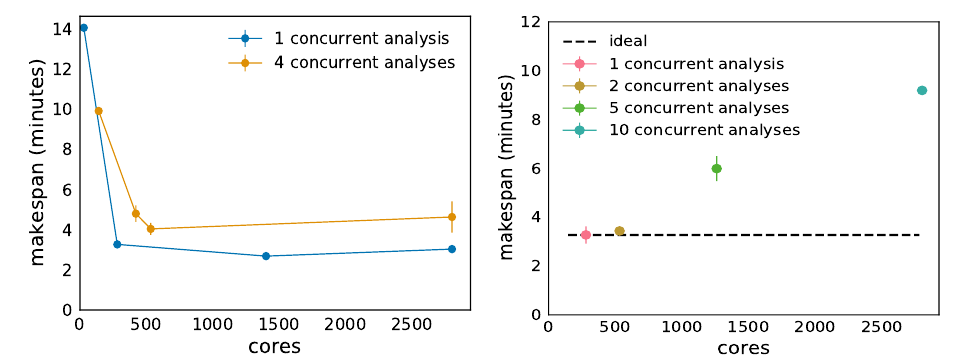
Figure 2. Two views of total execution time as a function of number of dedicated endpoint cores on Midway, for varying numbers of concurrent analyses. For strong scaling (left), number of concurrent analyses is fixed at 1 or 4. For weak scaling (right), number of cores per analysis is fixed for each point at ∼ 256. Error bars denote the standard deviation of time